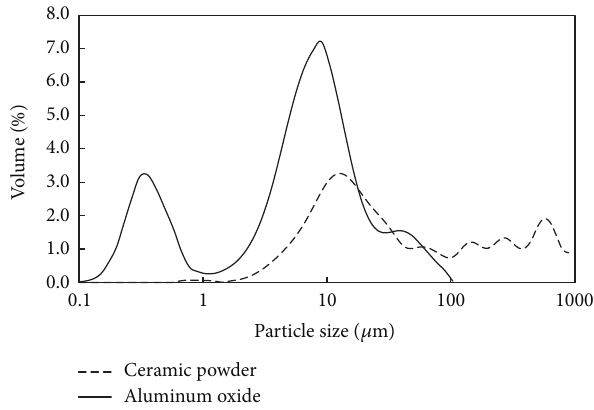
Figure 3: Particle size distribution of the powders. particles with sizes from 100 𝜇 m to 1000 𝜇 m. These coarse particles are probably formed due spray drying, where primary particles of smaller size agglomerate and generate ceramic granules of larger size. The mean Sauter diameters for alumina and ceramic powder are equal to 𝑑 𝑝𝑆 = 1.25 ± = 679 ± 29 𝜇 m, respectively. 0.01 𝜇 m and 𝑑 𝑝𝑆